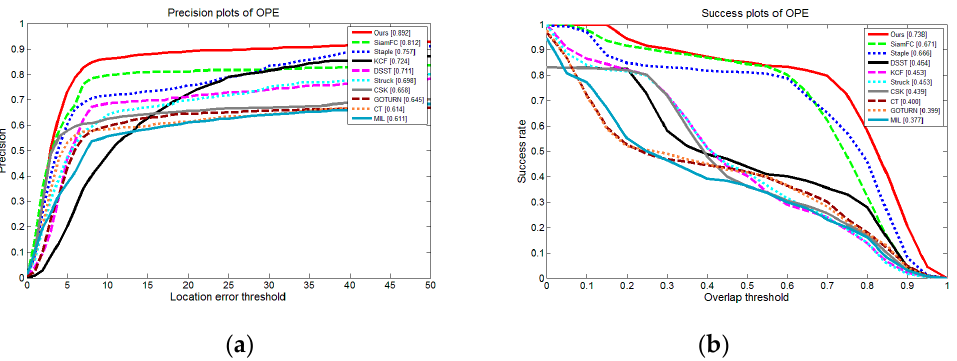
Figure 10. Results of different trackers on vehicle videos in OTB100: ( a ) one-pass evaluation (OPE) precision plots; ( b ) OPE success plots.